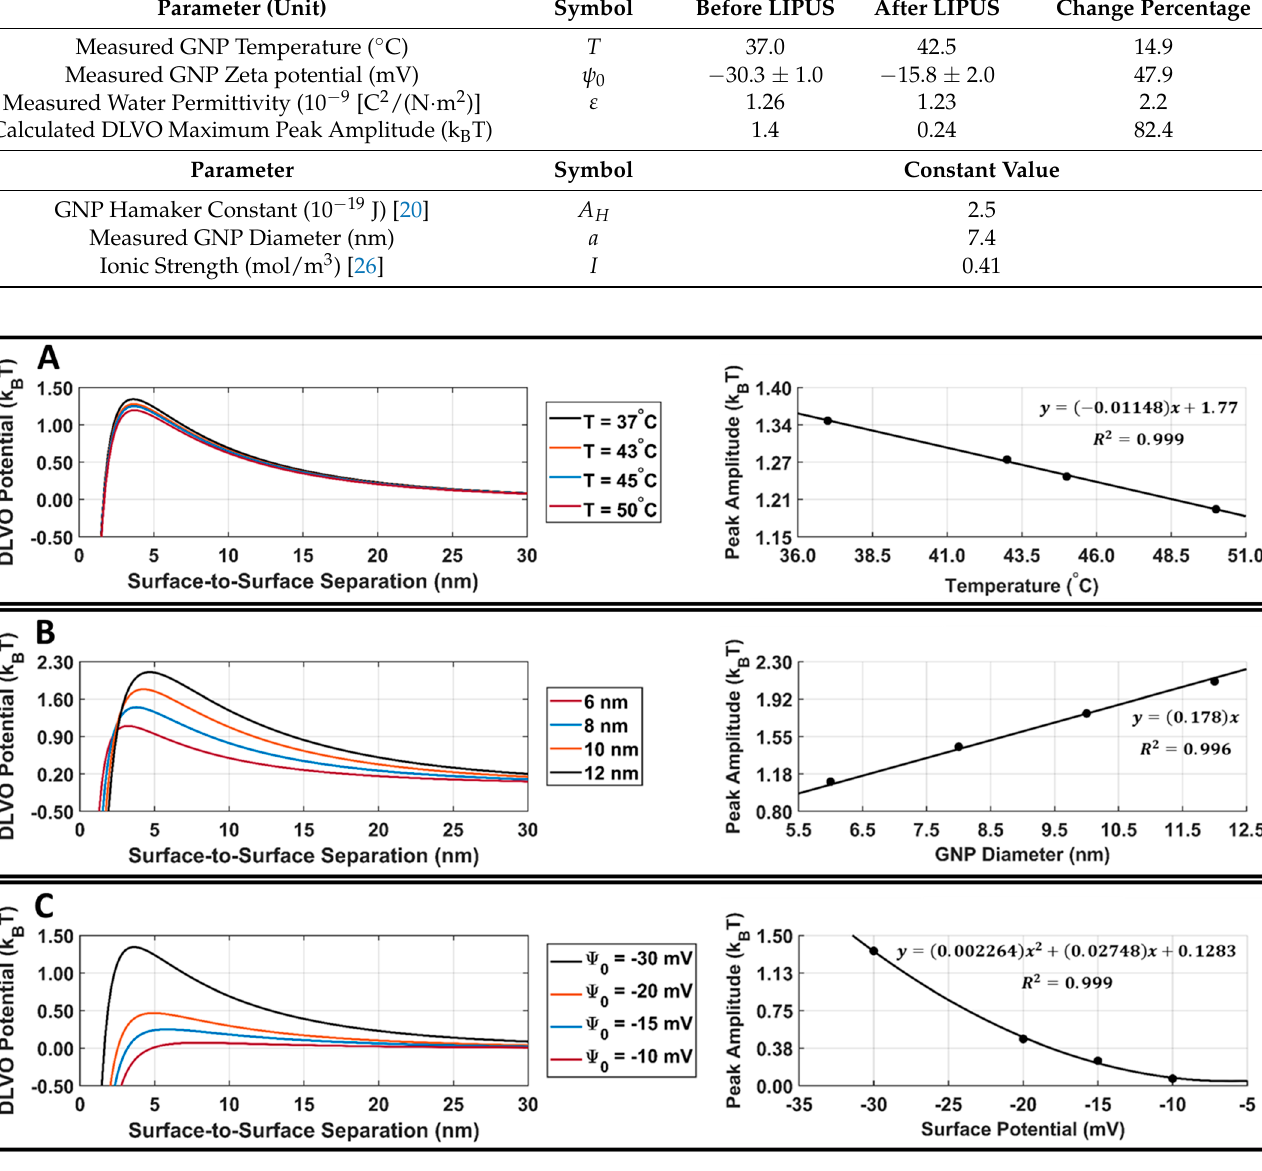
Figure 7. DLVO total interaction potential parametric study results for DOX-loaded GNPs. ( A ) DOX-loaded GNP surface potential is fixed at -30.3 mV, the diameter is fixed at 7.4 nm, and the temperature is varied. This surface potential and diameter were selected as they are the surface potential and diameter of our stable DOX-loaded GNPs. A linear fit of DLVO peak amplitude vs. temperature is also provided for reference purposes. ( B ) DOX-loaded GNP surface potential is fixed at -30.3 mV, the temperature is fixed at 37.0 ° C, and the diameter is varied. A linear fit of the DLVO peak amplitude vs. diameter is also provided for reference. ( C ) DOX-loaded GNP temperature is fixed at 37.0 ° C, the diameter is fixed at 7.4 nm, and the surface potential is varied. A second-order polynomial fit of the DLVO peak amplitude vs. surface potential is also provided for reference. The R 2 fit value is provided for all cases.